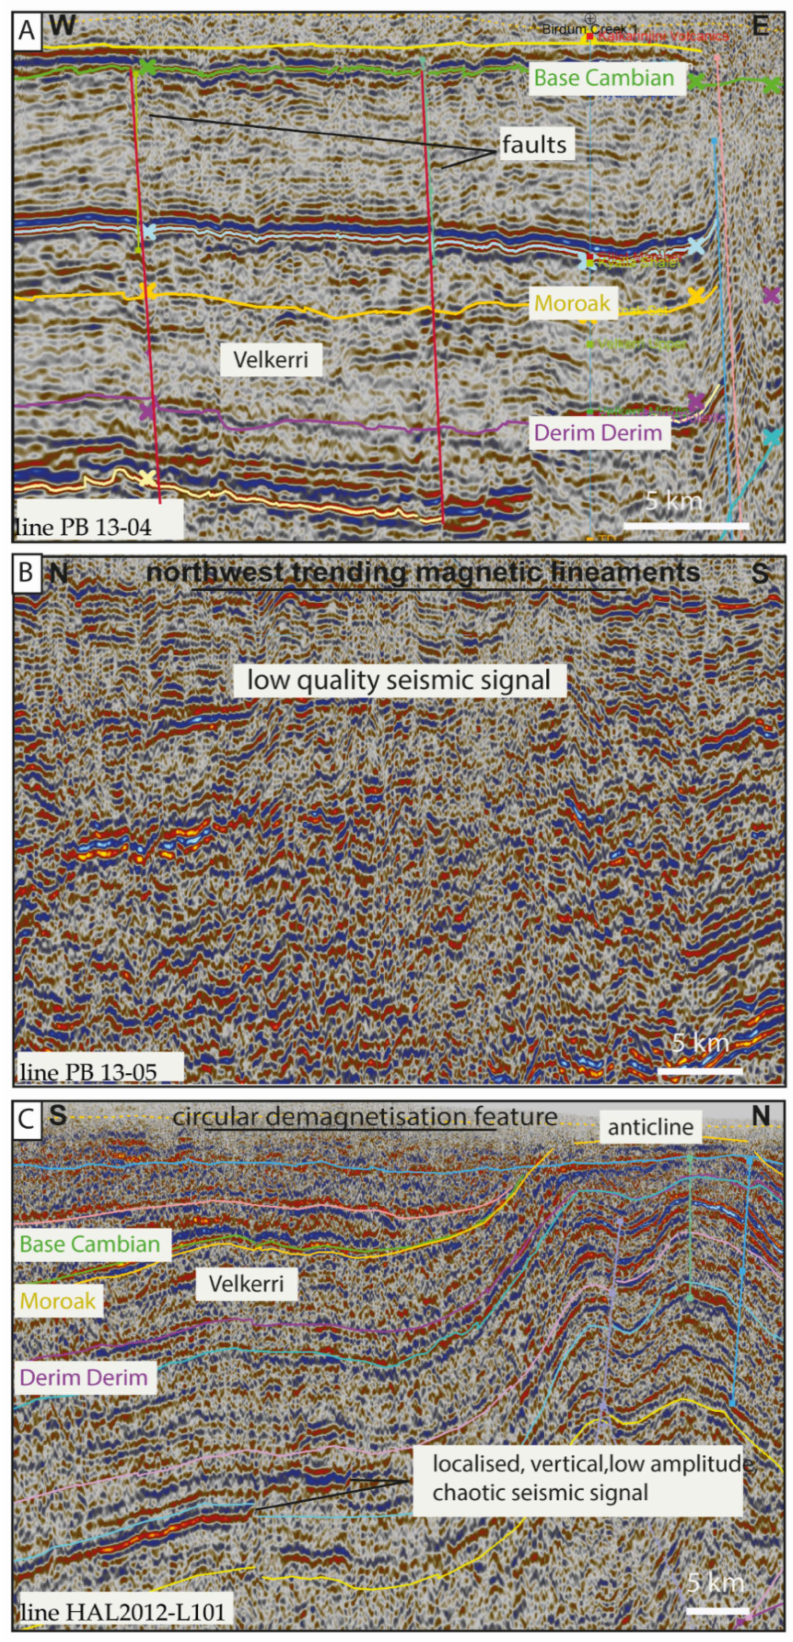
Figure 6. Details of the seismic interpretation in correlation with the magnetic interpolation at the top of the volcanics, see location on Figure 3B. ( A ) line PB 13-04; ( B ) line PB 13-05; ( C ) line